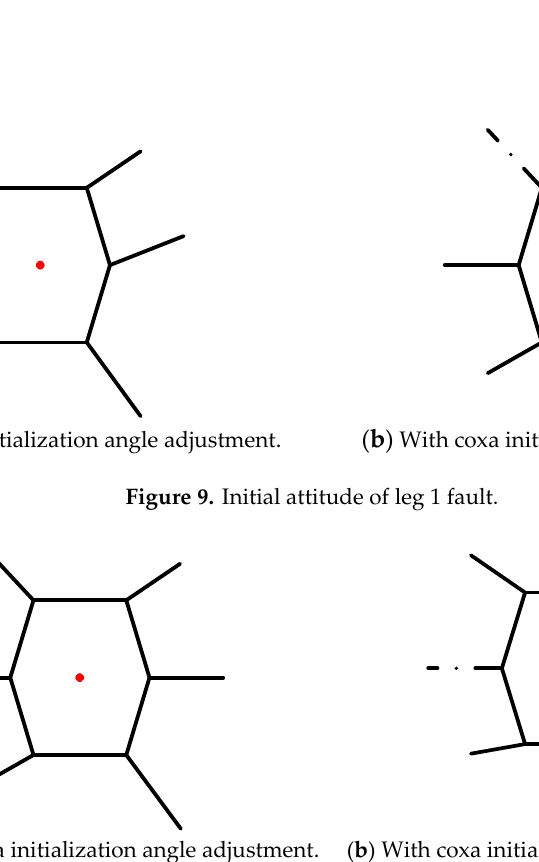
Figure 10. Initial attitude of leg 2 fault. Appl. Sci. 2020 , 10 , x FOR PEER REVIEW